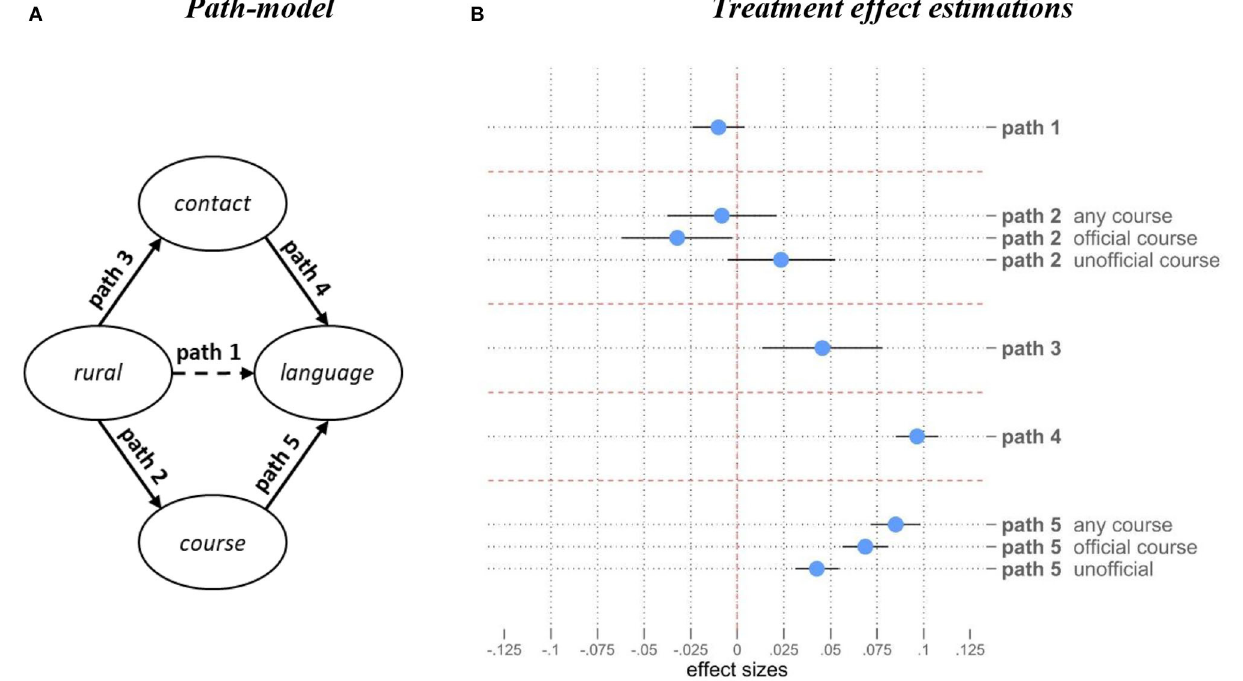
FIGURE 3 | A model for rural language acquisition – Treatment Effect Estimations. (A) Displays the theoretical model described in detail in section Theory, (B) shows average treatment effect (ATE) coefficients with their 95% confidence-intervals resulting from 9 separate regressions using the regression adjustment method (including population weights). Outcomes are all scaled as binary (0, 1), language-proficiency is scaled as an index taking values between 0 and 1 (path 1, 4, 5). Non-displayed controls are included for respondents’ sex, age, educational-levels, number of children, country of birth, years since immigration, legal status, partnership status and moving indicator. N = 13,187